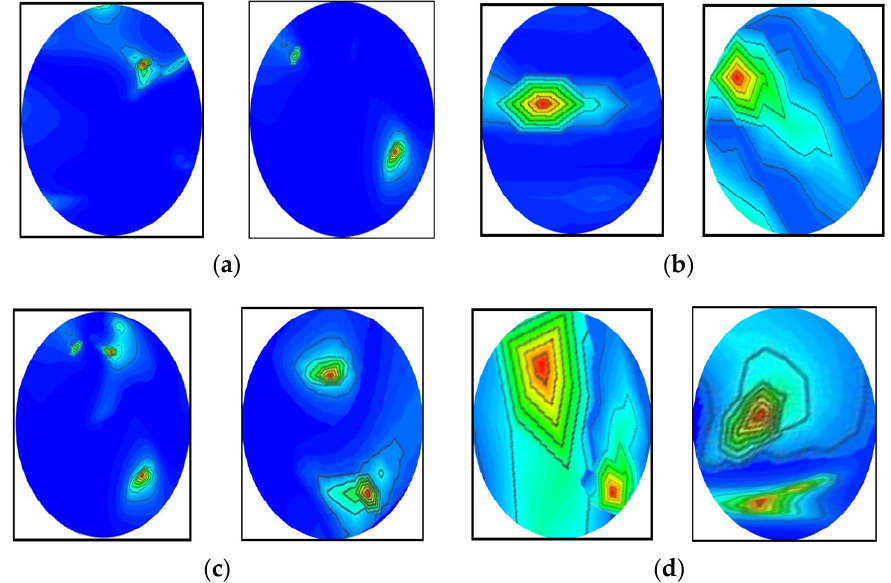
Figure 11. Some misclassified image samples by the MBINet model for the raw RMB images: ( a ) BT images were misclassified as a NT class, ( b ) MT images were misclassified as a BT class, ( c ) BBT images were misclassified as a NT class, and ( d ) MMT images were misclassified as a BBT class.